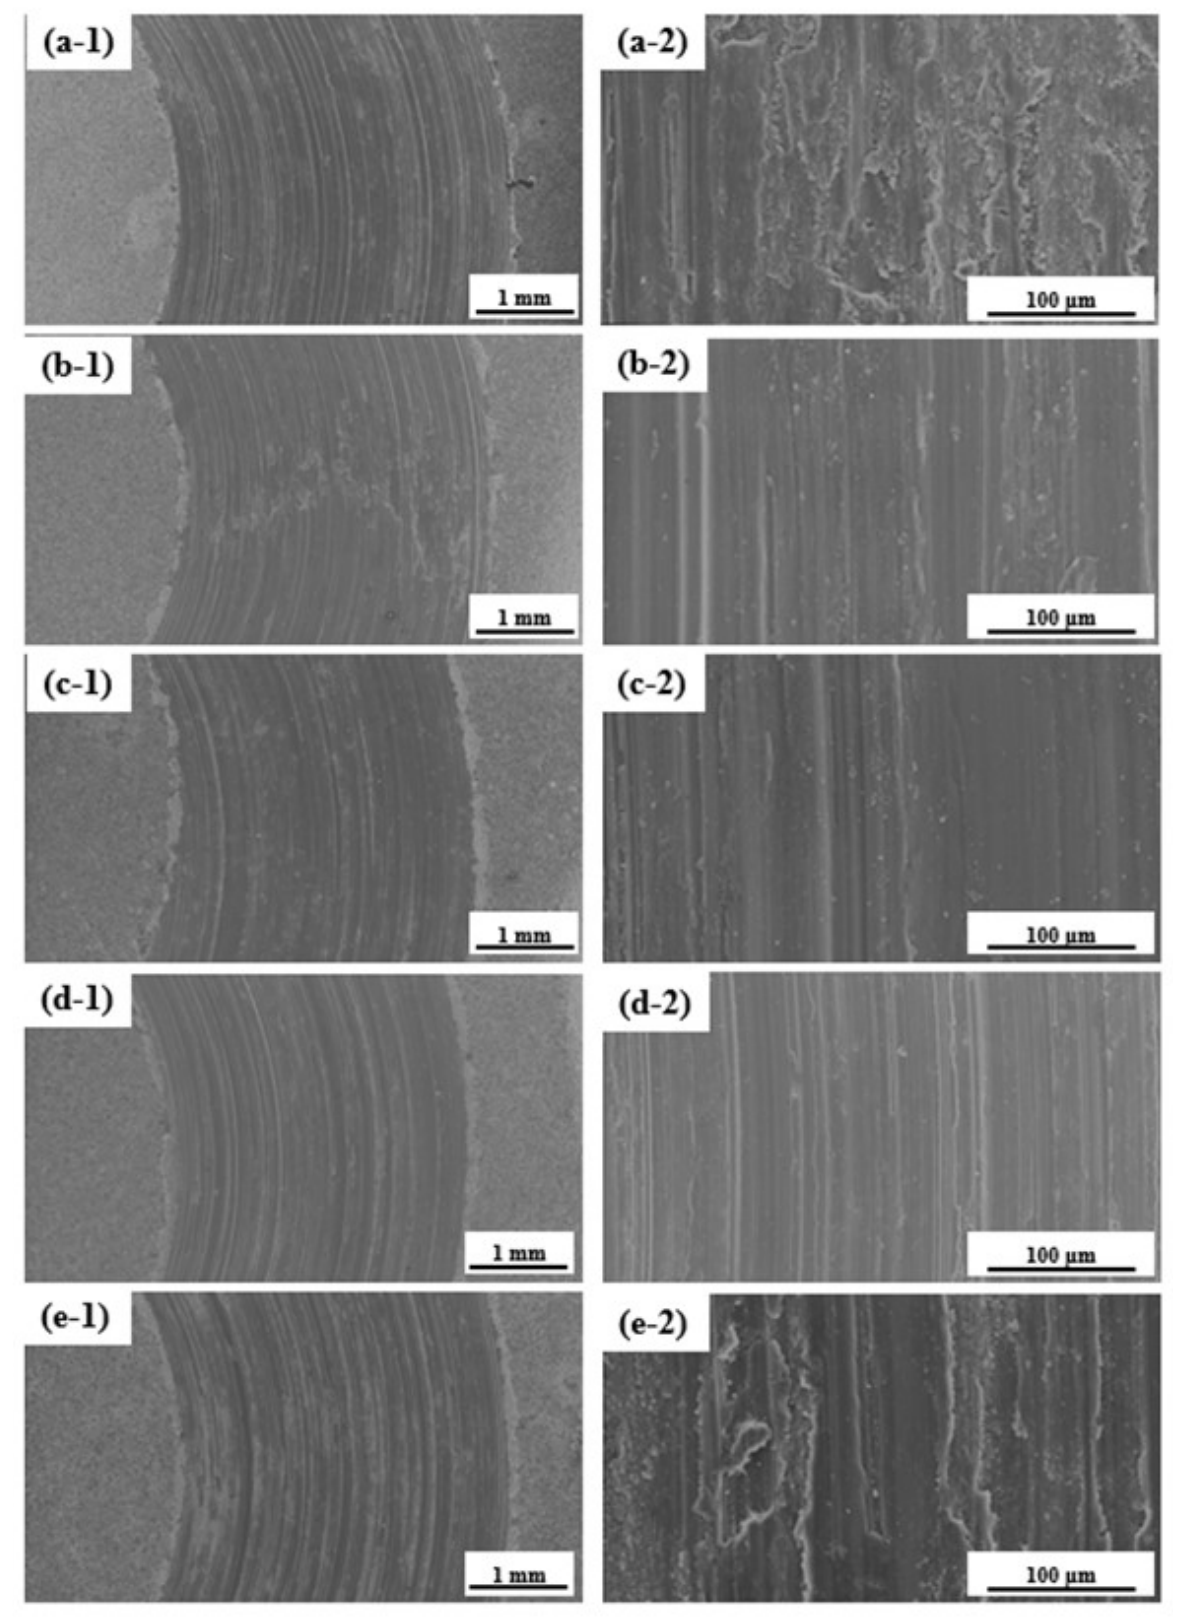
Figure 15. Wear distance and morphology of the coated samples: 0 ( a ), 1 ( b ), 2 ( c ), 3 ( d ), and 4 ( e ) g/L TiO 2 .